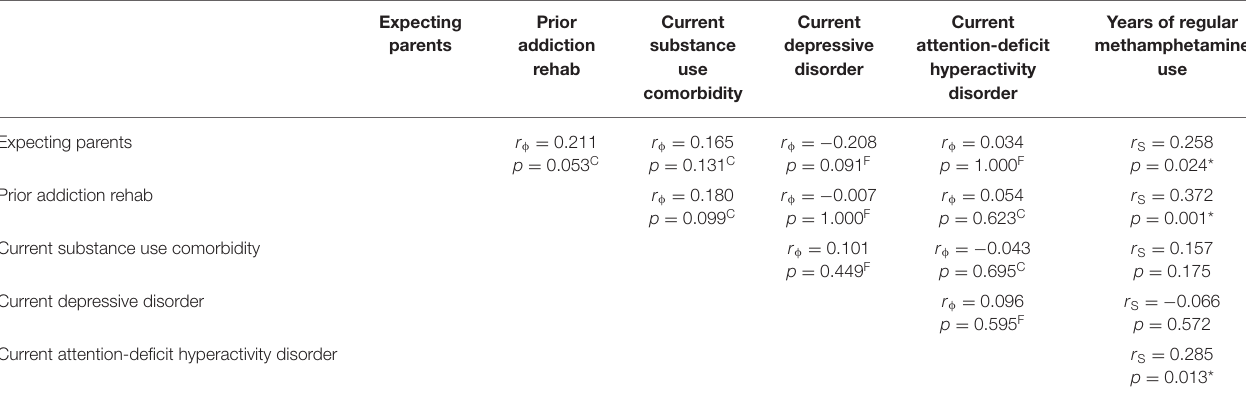
TABLE 3 | Associations between correlates of